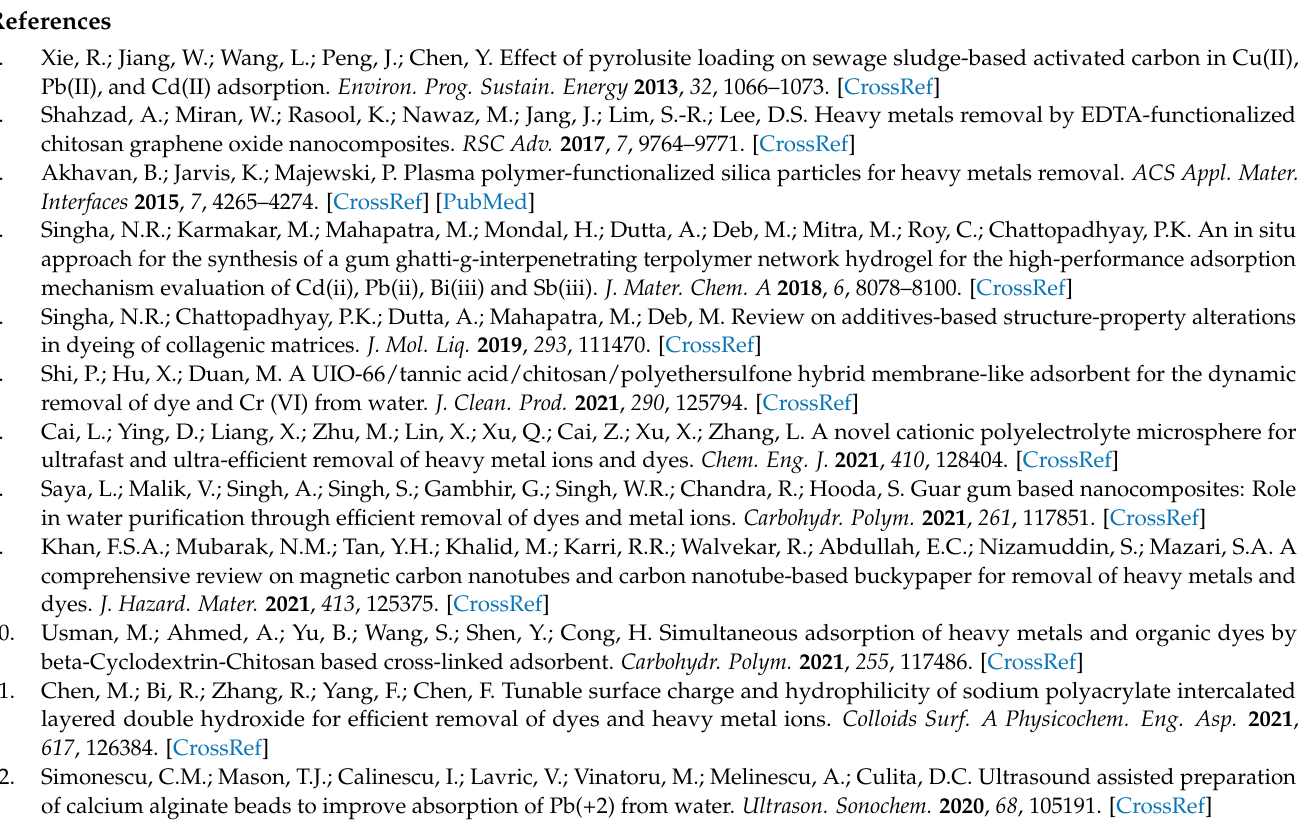
Figure S2. Effect of different salt ions on the adsorption capacity of FSAH for to adsorb Pb 2+ (a), Cd 2+ (b), Cu 2+ (c), MB (d), MG (e), and CV (f) [50–54]. Table S5. EDS-mapping parameters of SA and FSAH, respectively. Table S6. Comparison with other adsorption materials